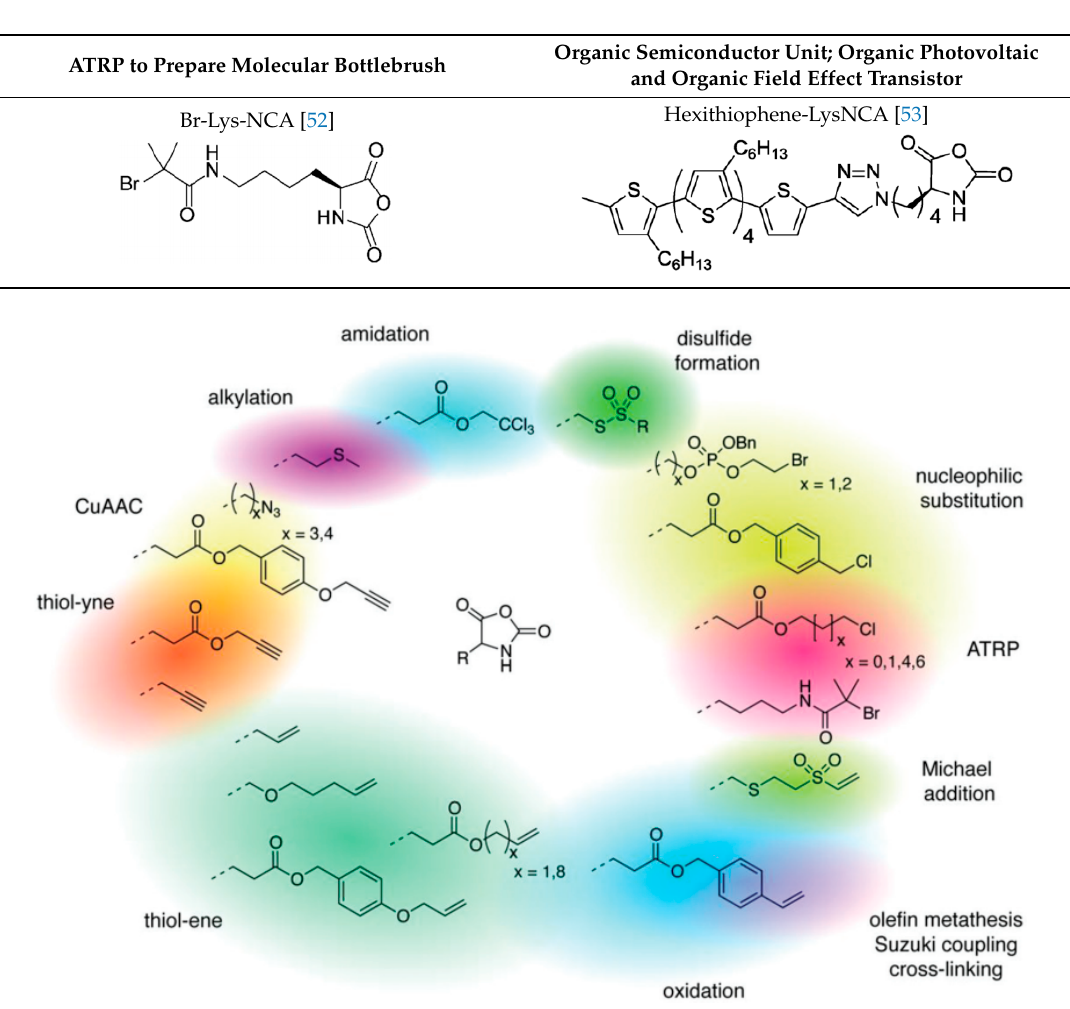
Figure 4. General overview of the functional NCAs and the corresponding chemical modifications that they may undergo. Reproduced with permission from reference [14].